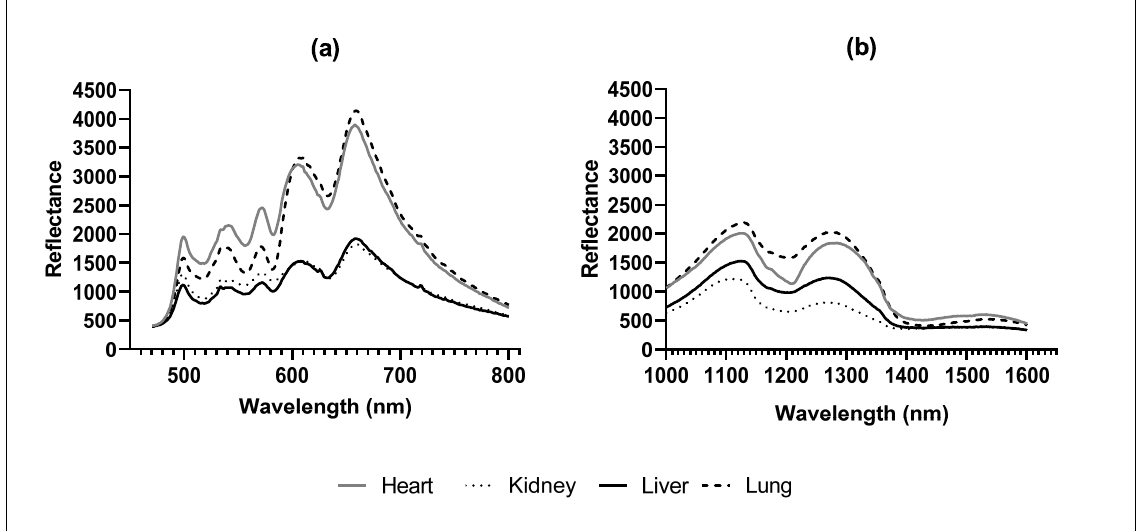
Figure 2. Trimmed centred moving average ( a ) visible (470.5–800.5 nm); and ( b ) short-wave infrared